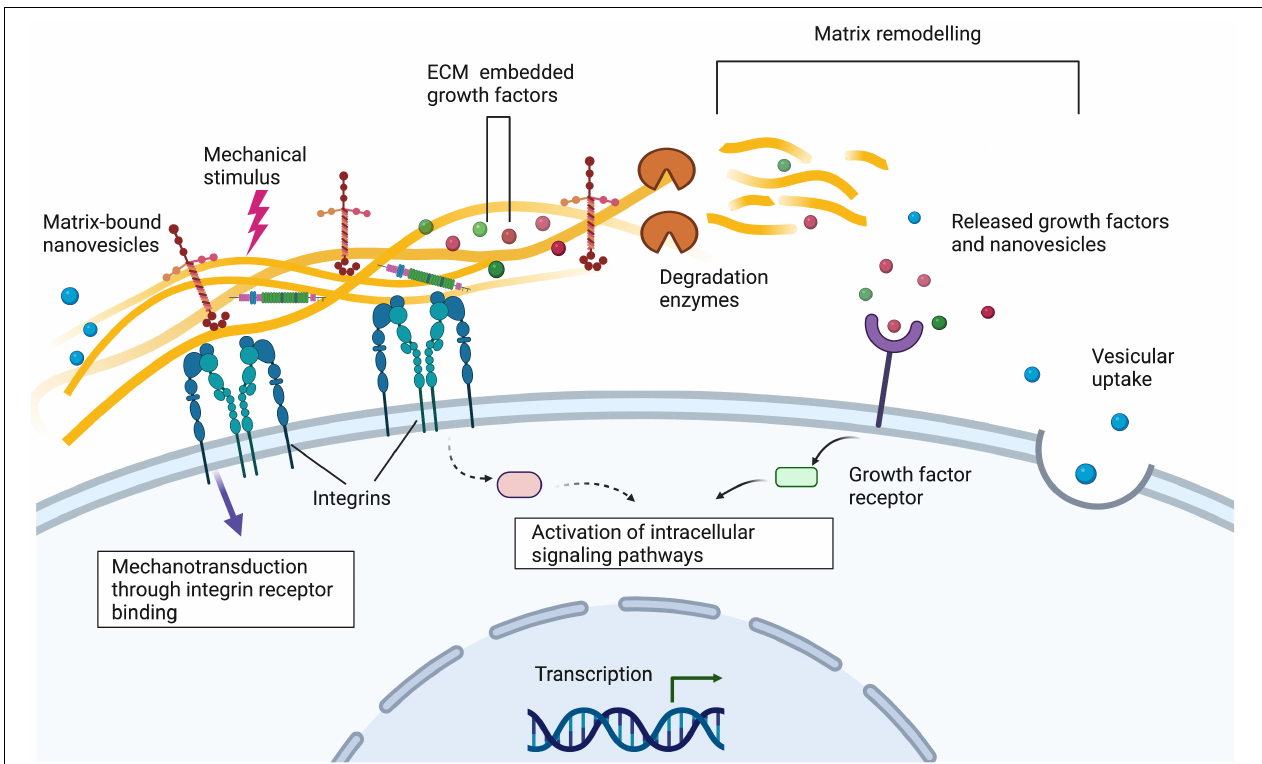
FIGURE 2 | Integrins on the cell surface bind to extracellular matrix proteins such as laminin and collagen. Alterations to the extracellular matrix via matrix remodelling, the addition of matrix-bound nanovesicles and growth factors and mechanical stimuli can alter cellular behaviour. Understanding these interactions is important when designing nerve guidance constructs for peripheral nerve tissue engineering applications. Created with